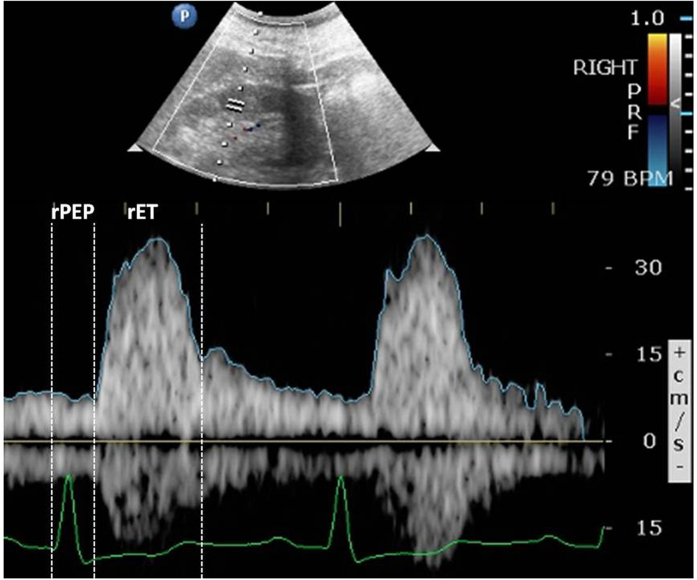
The renal pre-ejection period (rPEP) was measured from the onset of the QRS complex to the foot of the renal pulse Doppler waveform.The renal ejection time (rET) was measured from the foot to the dicrotic notch of the renal pulse Doppler waveform.